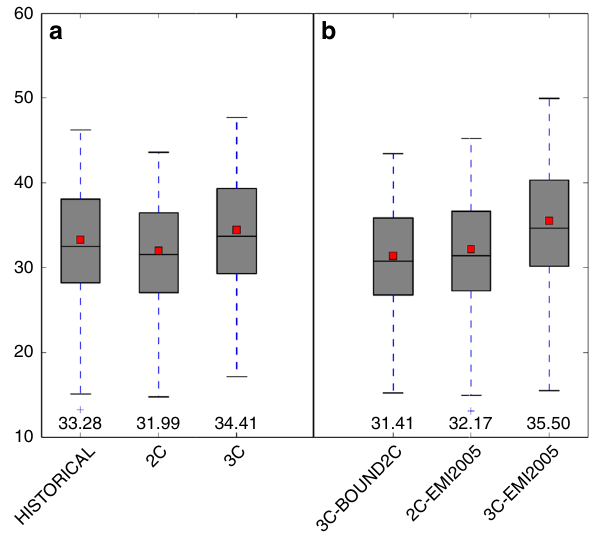
Fig. 1 Distribution of annual mean European ozone concentrations. Distribution of annual mean European ozone land concentrations for each of a the main scenarios HISTORICAL, 2C, and 3C and b the sensitivity tests 3C-BOUND2C, 2C-EMI2005, and 3C-EMI2005, in ppbv. Filled boxes indicate the interquartile range, the whiskers indicate the full range, the line and square , respectively indicate the median and the mean. Numbers at the bottom of the fi gure also indicate the means, calculated from the 30-year period of the different scenarios. The different scenarios are described